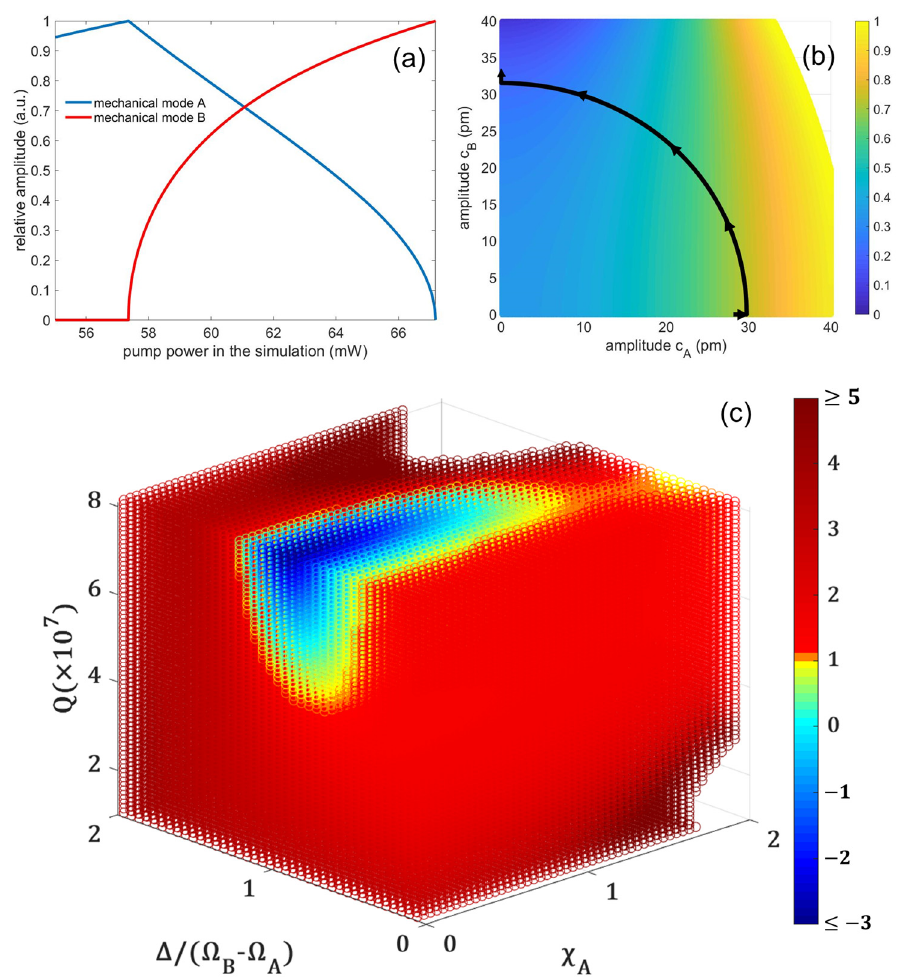
Figure 1. ( a ) Simulation results of the relative amplitudes of mechanical modes A (blue curve) and B (red curve) as a function of pump laser power. ( b ) Weak coupling region (in different color) between the two mechanical modes, and the black curve is the trajectory of the intensity of the two mechanical modes in ( a ). ( c ) Coupling coefficient between the two mechanical modes as a function of the optical mode Q value, the pump laser detuning, and the dimensionless amplitude of the mechanical mode A. The red and orange correspond to the strong coupling region and the other colors to the weak coupling region.